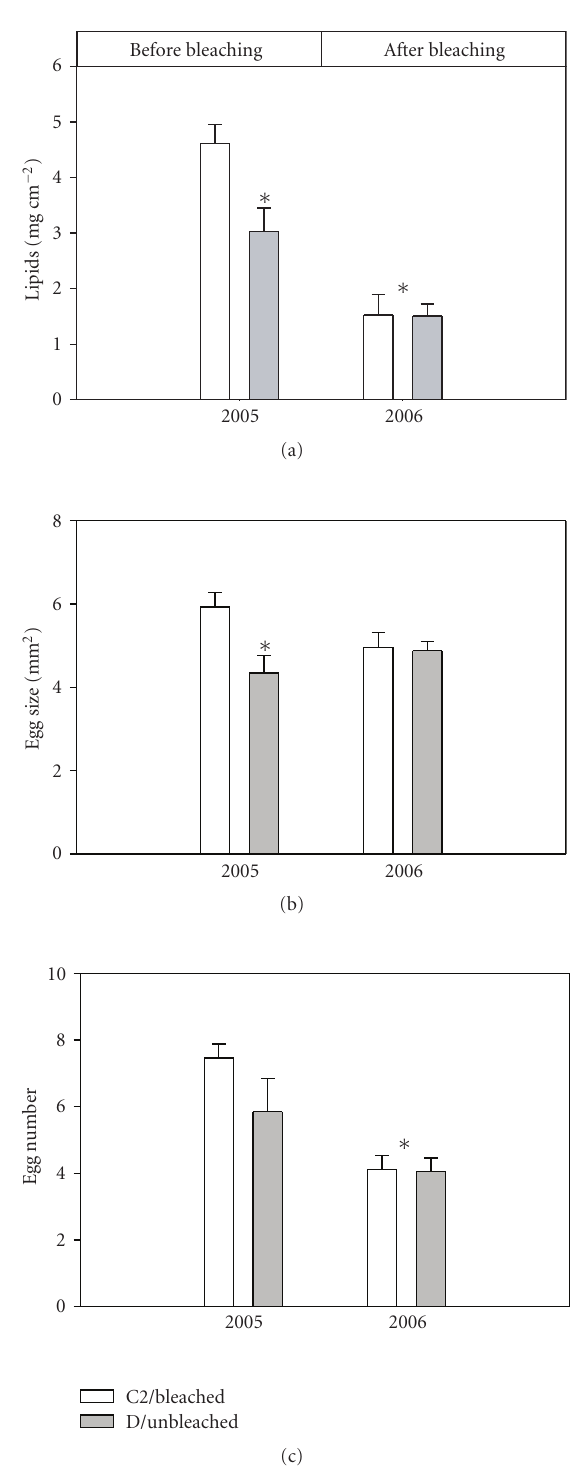
Figure 5: (a) Lipids, (b) egg size, and (c) egg numbers in colonies of Acropora millepora before and after a bleaching event that occurred in February 2006. White bars represent colonies with predominantly C2 symbionts before the bleaching that bleached white and grey bars represent colonies with predominantly D symbionts before the bleaching that were unbleached during the event. Whisker bars above the bars represent the standard error of the mean. ∗ represent significant di ff